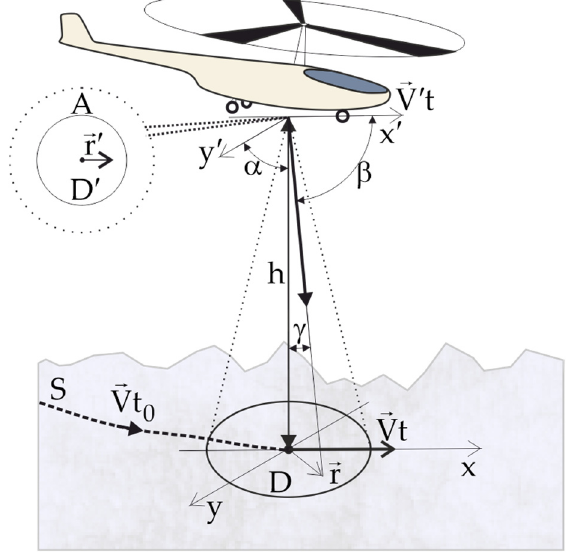
Figure 1. Physical parameters and geometric relationships used in the synthesis of the helicopter altitude measurement algorithm.